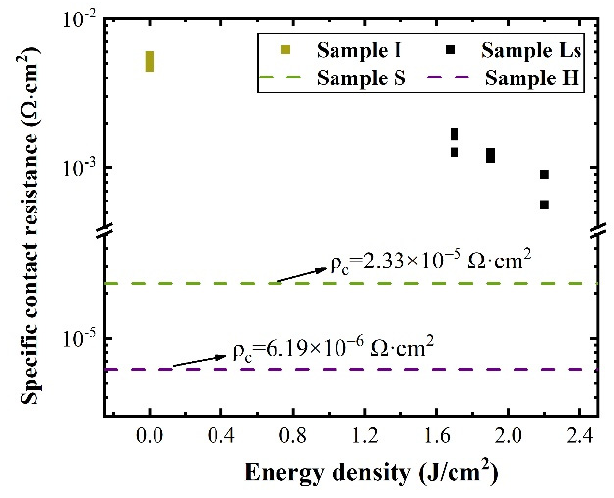
Figure 3. Specific contact resistivity as a function of energy density.